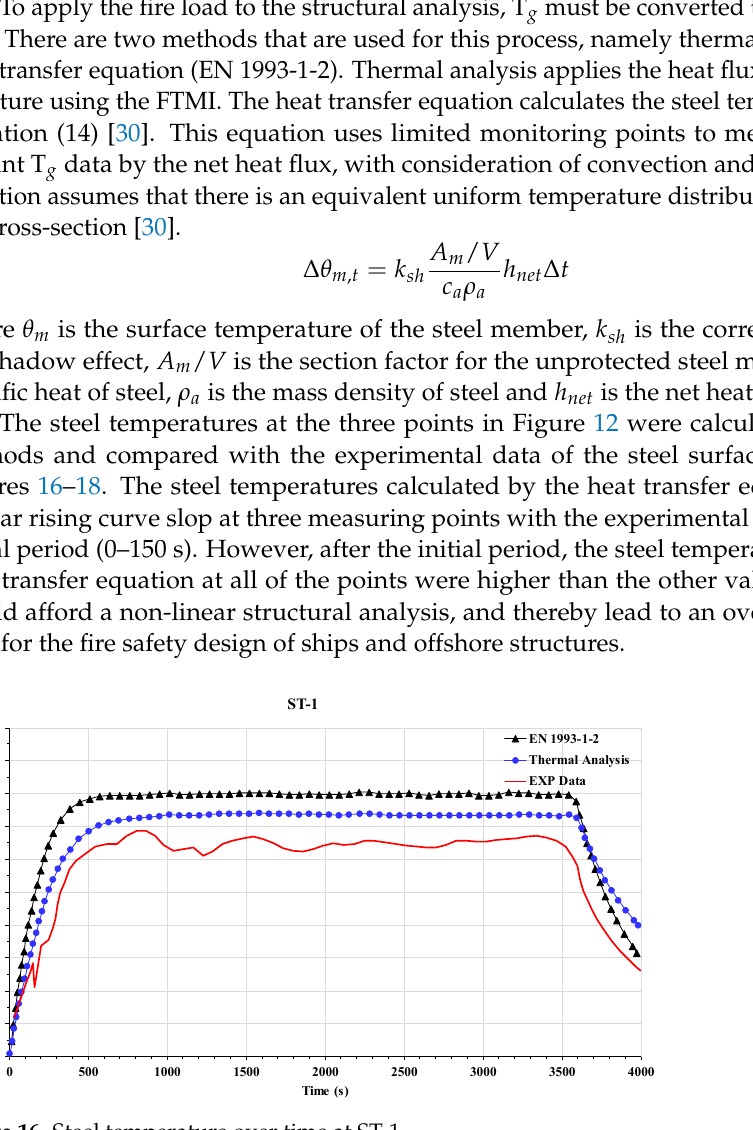
Figure 16. Steel temperature over time at ST-1.